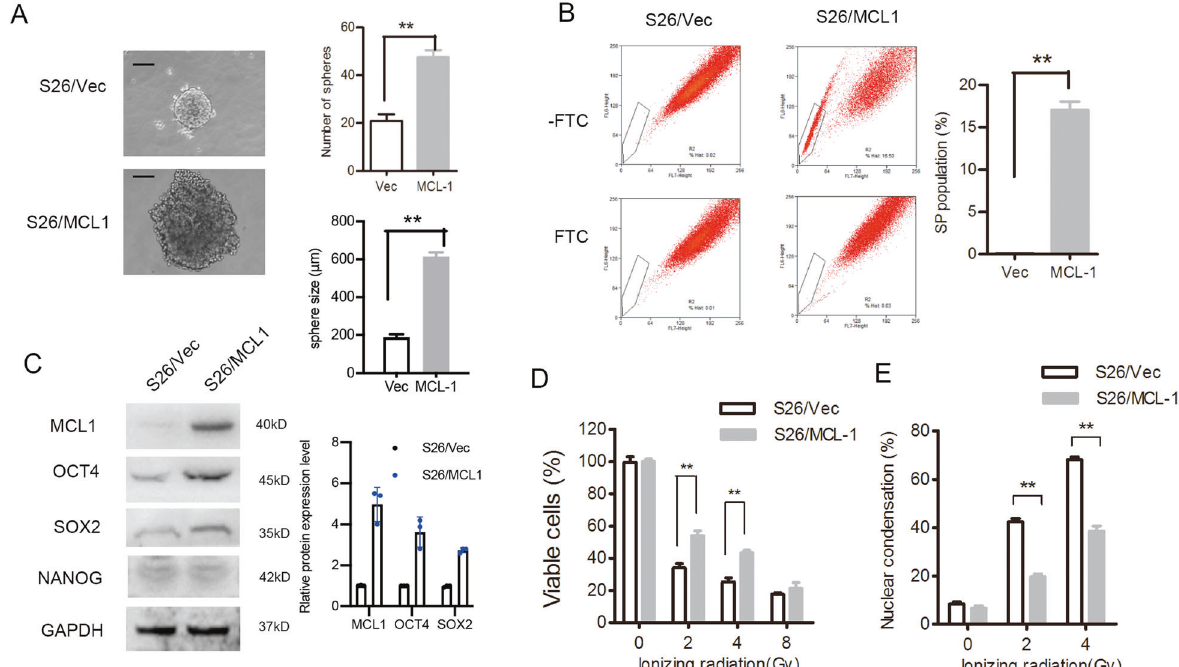
Fig. 4 Expression of MCL-1 in NPC cells induced CSC characteristic and radiation resistance. S26 cells stably overexpressing MCL-1 or empty vector (Vec) were analyzed as follows. A The representative images of single-cell suspensions are shown (left panel) and spheroids were counted (right upper panel), and the size were measured (right lower panel), ** p < 0.01, Student ’ s t -test. B Percentages of SP cells are shown in the left panel, and the right panels compare the populations of SP, n = 3, * p < 0.05, Student ’ s t -test. C Protein levels of stem-cell markers